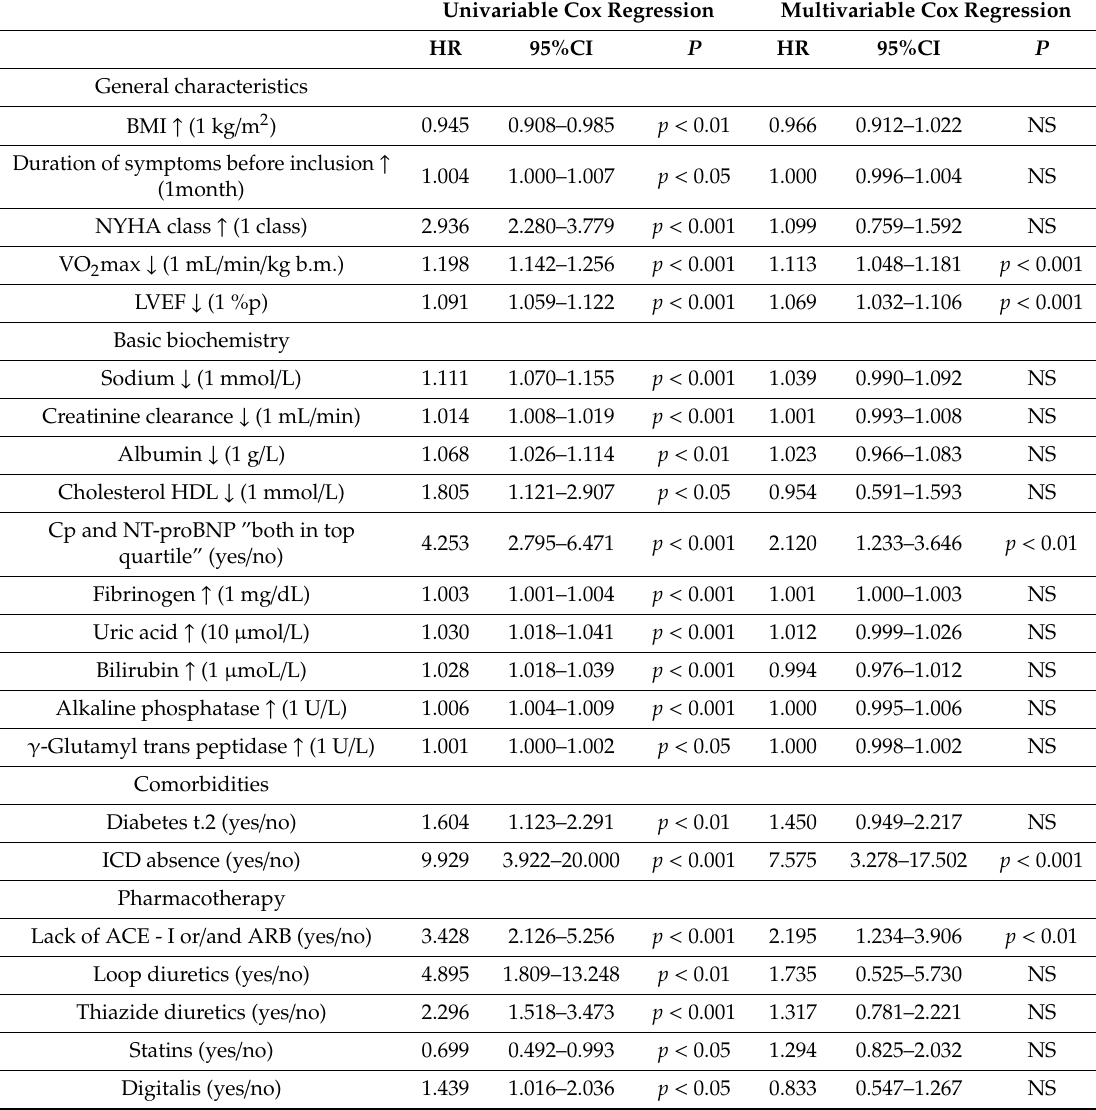
Table 3. Predictors of death or heart transplantation in one-year follow-up. The results of uni- and multivariable Cox regression analysis,